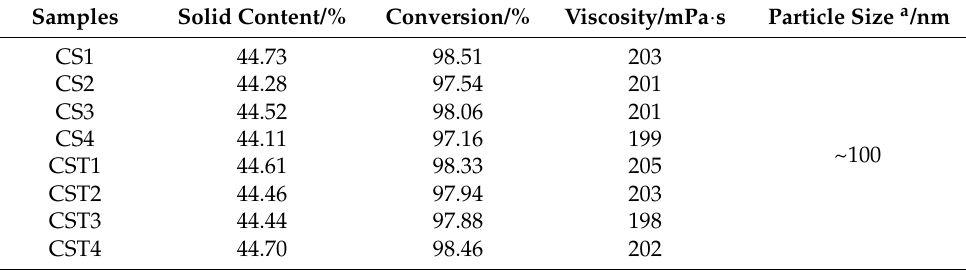
Table 3. Characteristics of the core/shell latex.